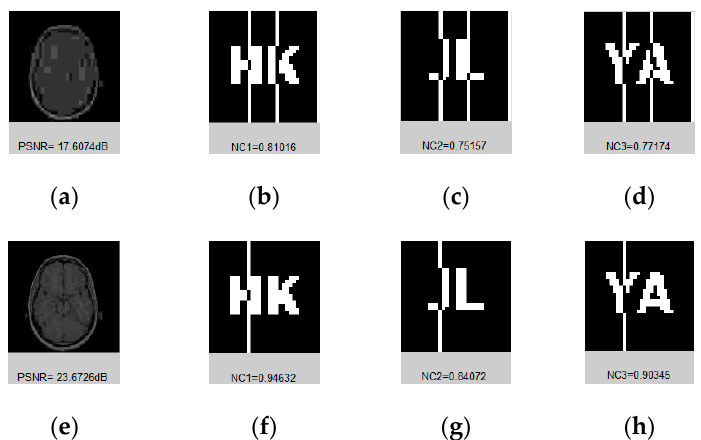
5 of 23 Figure 15. Under Gaussian noise attacks: ( a ) Gaussian noise level of 1%; ( b ) the extracted watermark